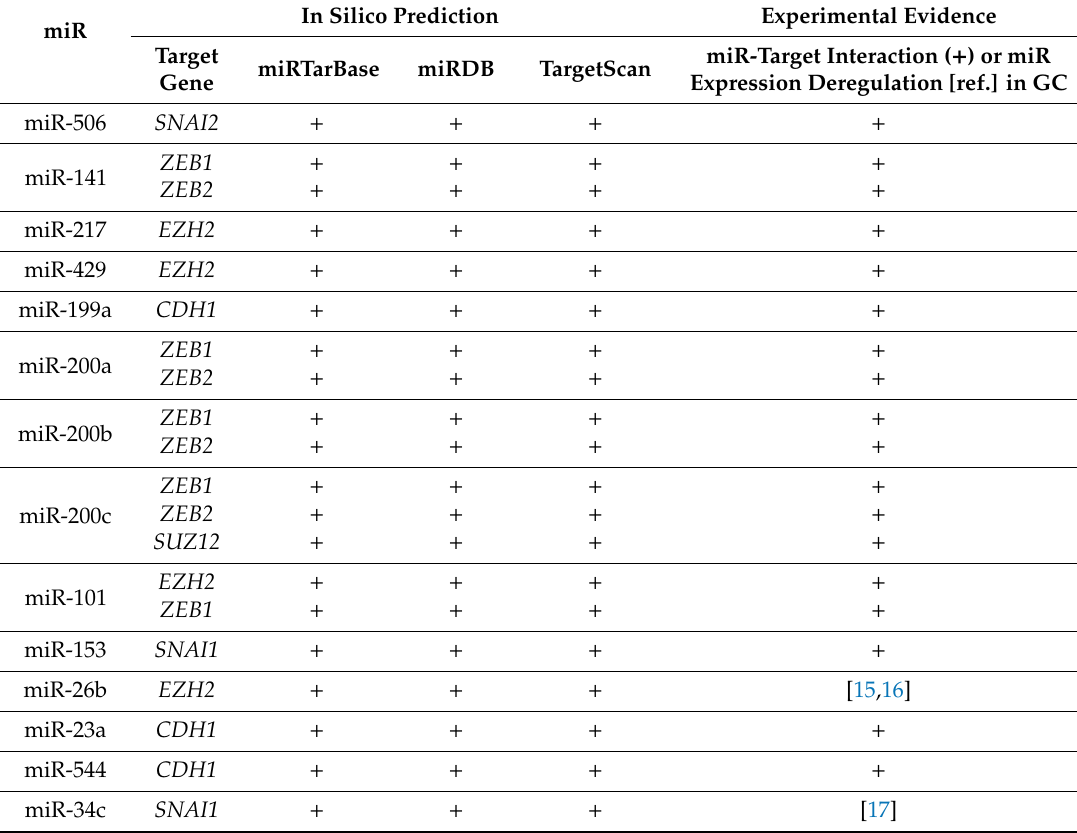
Table 2. Selected miRs, target genes, and rationale of